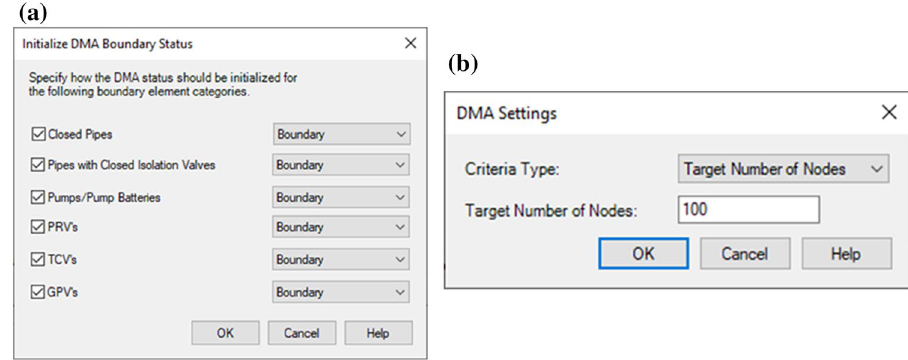
Fig. 3 a Initialize DMA Bound- ary Status dialog box and b DMA Settings dialog